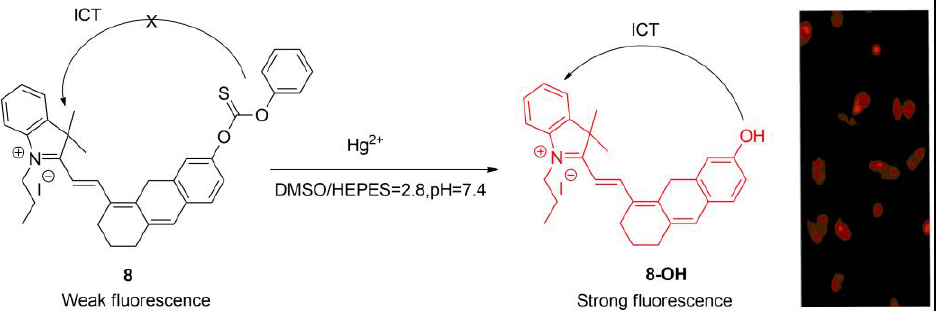
Figure 8. Response mechanism of probe 8 to Hg 2+ . A549 cells incubated with 8 (10 μM) for 30 min, and continually incubated with Hg 2+ (100 μM) for 60 min. Adapted with permission from [ 53]. Copyright (2020) Elsevier.